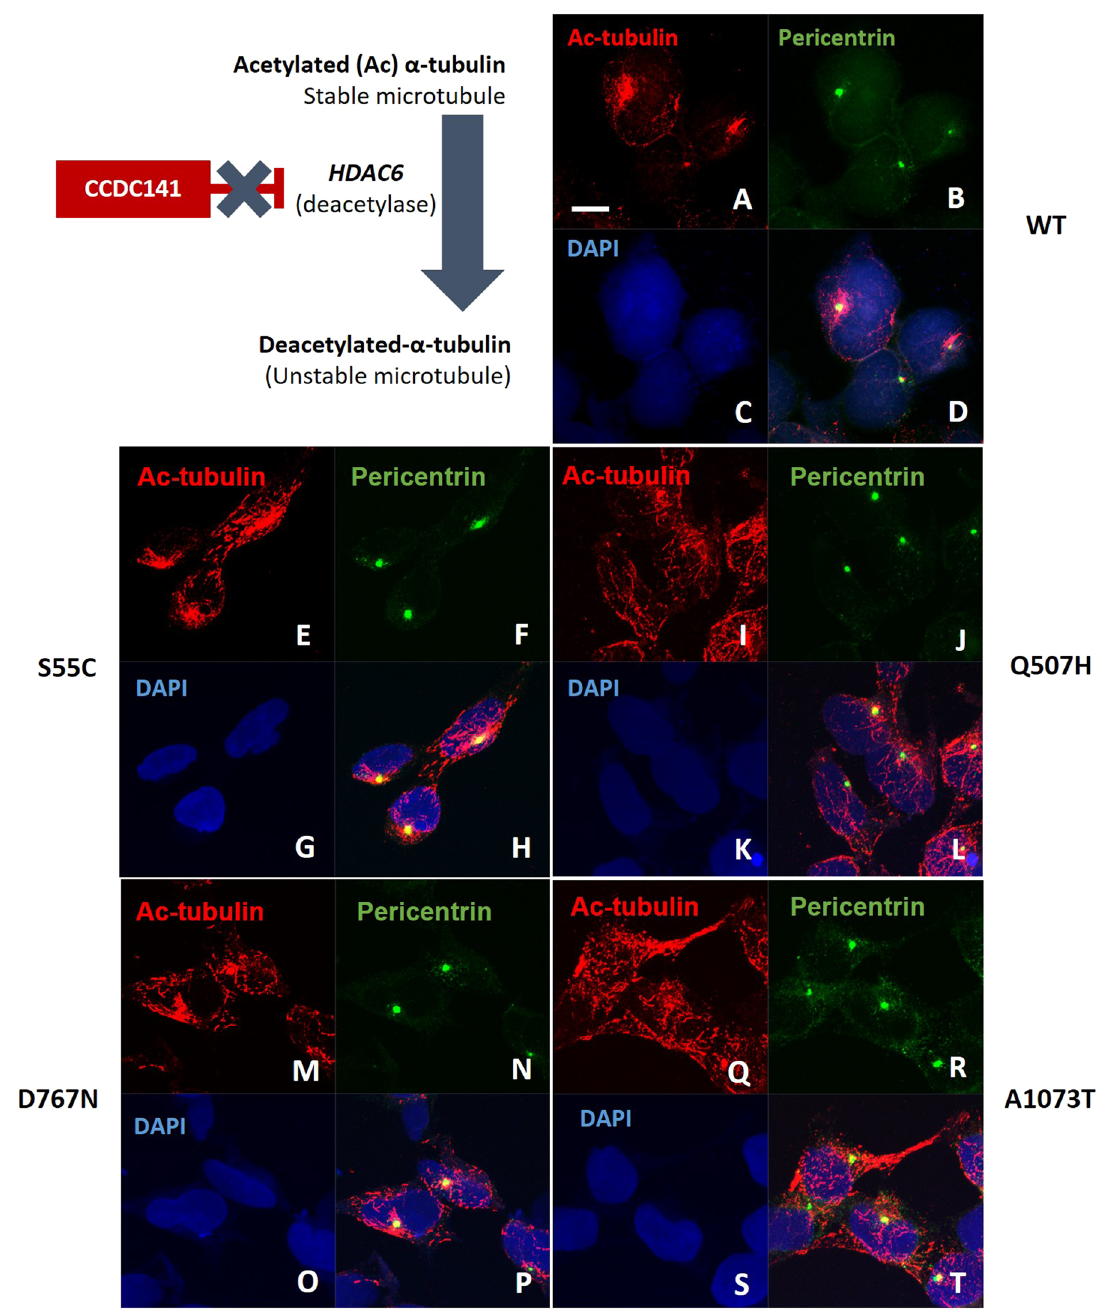
Fig. 4 Abnormal Ac-tubulin distribution in CCDC141 variants-expressing cells. The location and accumulation of Ac-tubulin was assessed by immuno fl uorescence staining of Ac-tubulin (Red) in HEK293 cell lines with stable expression of CCDC141 , WT ( A – D ), p.Ser55Cys ( E – H ), p. Gln507His ( I – L ), p.Asp767Asn ( M – P ), and p.Ala1073Thr ( Q – T ). The Centrosomal area was marked by pericentrin (Green) and nucleus was marked by DAPI (Blue). Scale bar in A (applies to all), 10